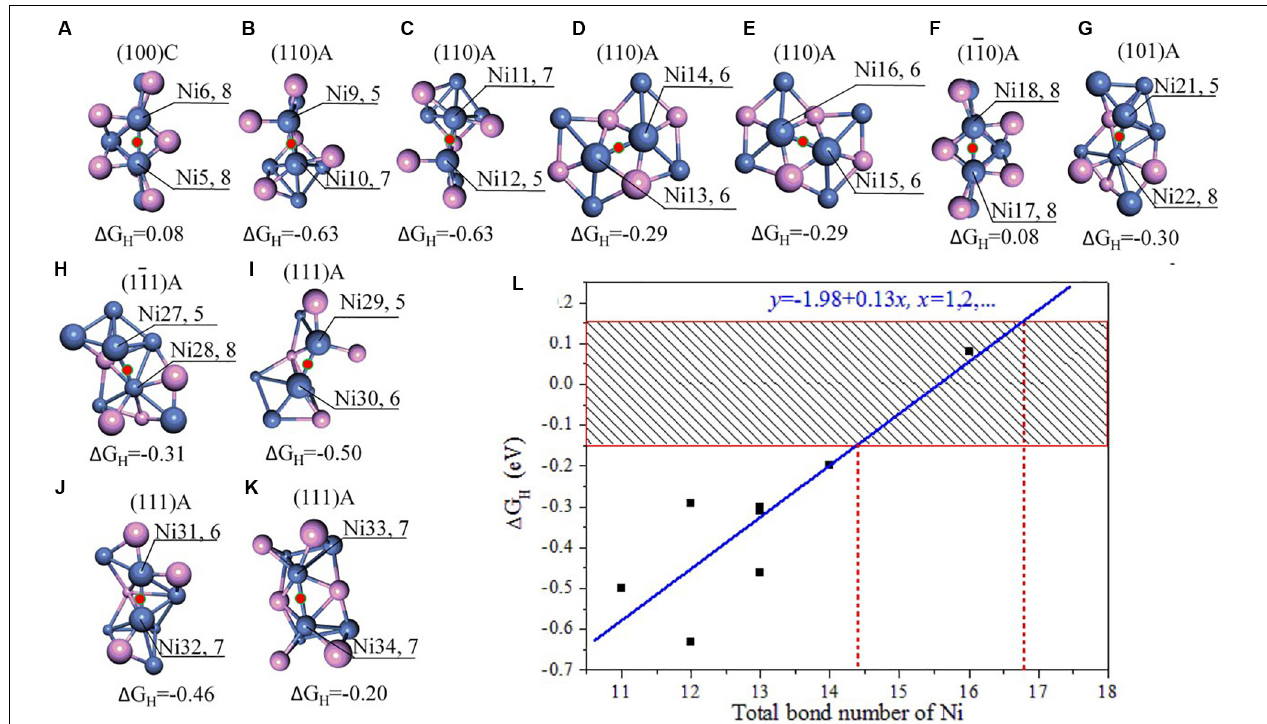
FIGURE 8 | (A–K) Stable adsorption sites with bridge NiNi. (L) the relationship between the bond number of Ni and 1GH. Reproduced from Hu et al. (2019) with permission from Copyright Frontiers Media